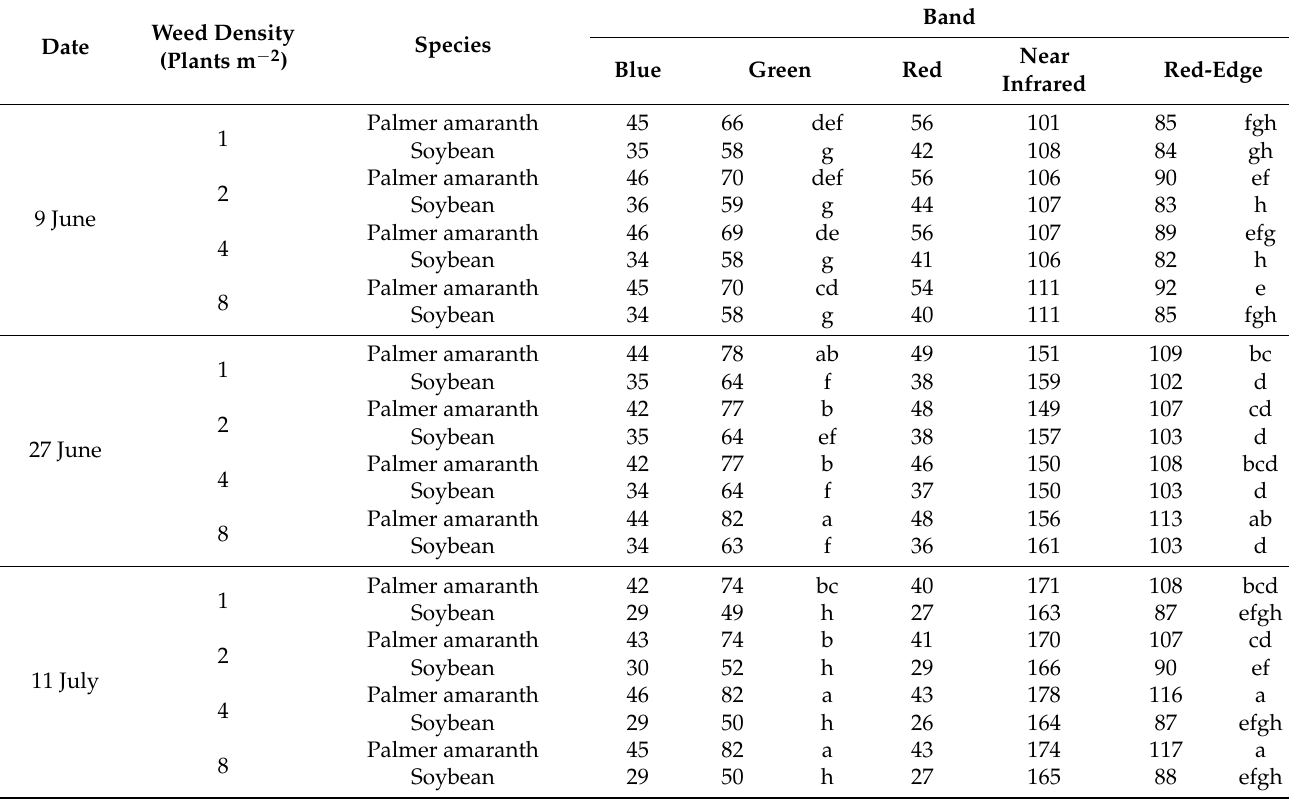
Table 7. Spectral reflectance values of Palmer amaranth and soybean across dates and Palmer amaranth densities from aerial imagery collected from an unmanned aerial vehicle at an altitude of 15 m at Rocky Mount, NC in 2017